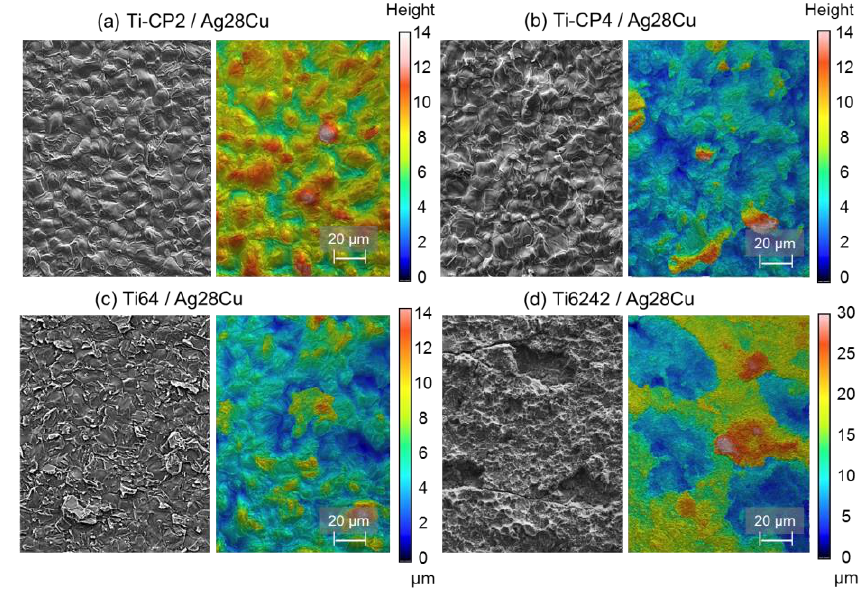
Figure 6. Fracture surfaces of the samples halves without the Ag-rich regions (excluding joint): Fractographs obtained by SEM (left image of each subfigure) and height profiles measured by confocal laser scanning microscopy (right image of each subfigure).